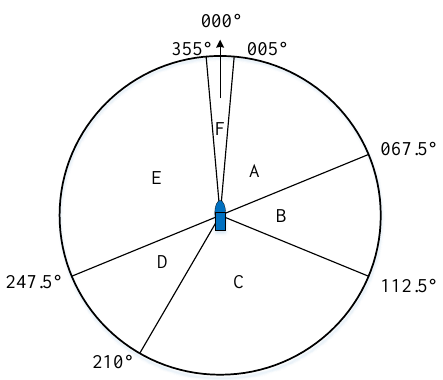
ff erent ship encounter Figure 2. The classification of different ship encounter scenarios. Figure 2. The classification of di